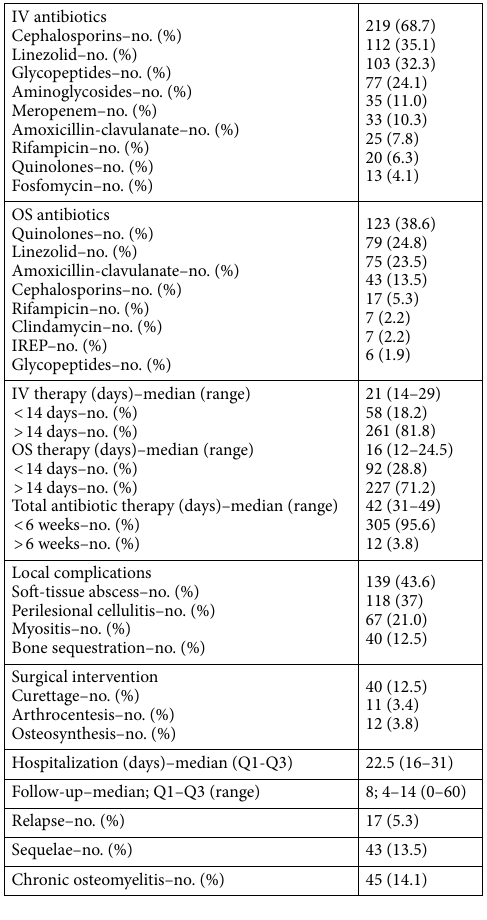
Table 2. Treatment, follow-up, complications and